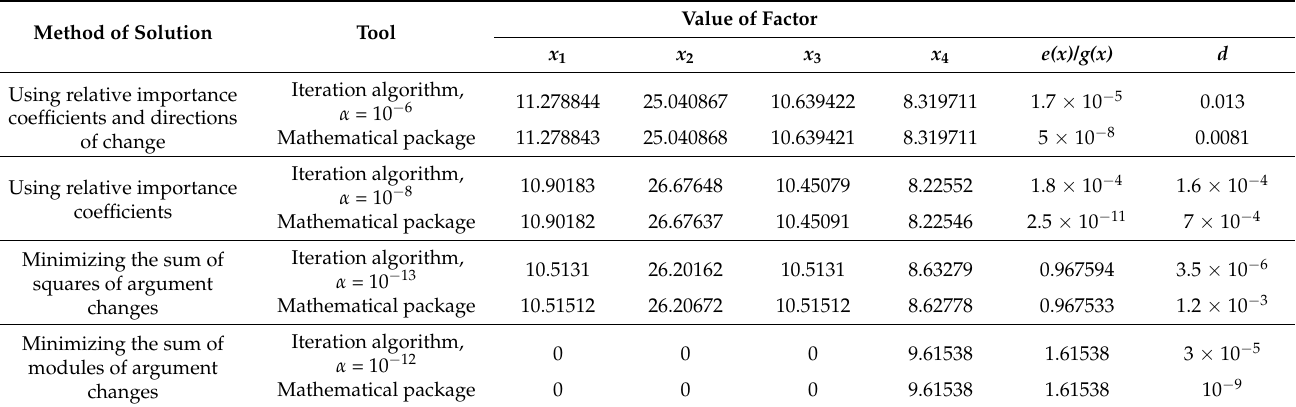
Table 1. The results of computational experiments for multiplicative